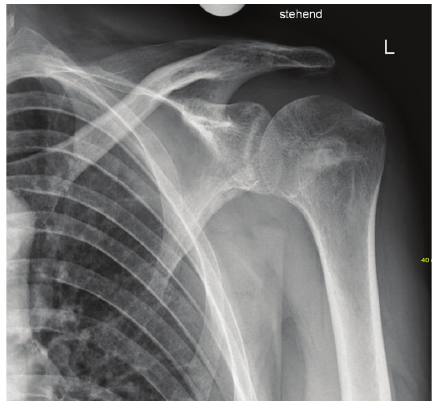
Figure 6: X-ray (a.p. view) at 6-month follow-up documenting the bony remodeling of the bone